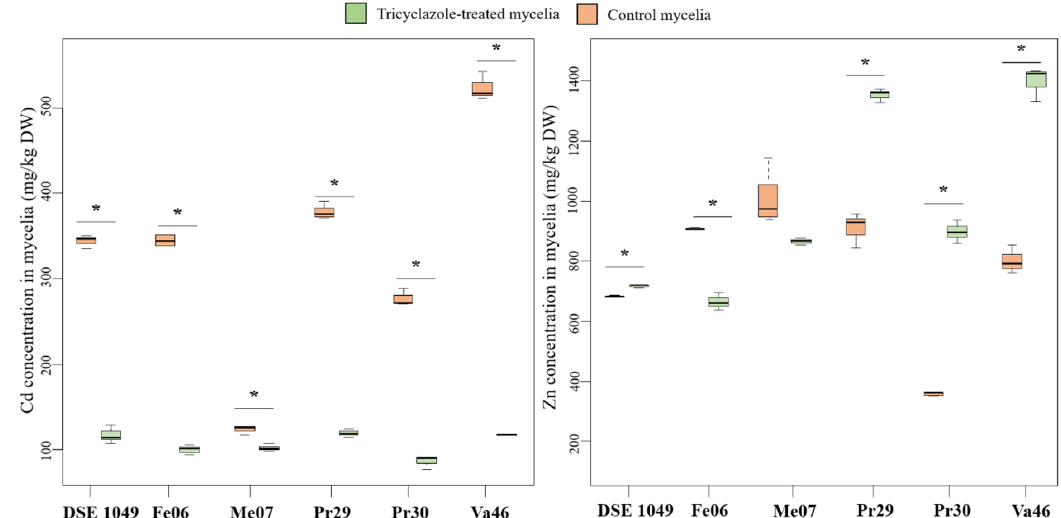
Figure 6. Concentration of Cd and Zn in control and tricyclazole-treated mycelia of six DSE strains. Values are medians ± quartiles ( n = 4). Cultures were performed in Pachlewski medium for two weeks and exposed or not to 200 μ M Cd or 1 mM Zn. Significant differences between control and tricyclazole treated-mycelia are denoted by stars ( p < 0.05, Kruskal–Wallis test).